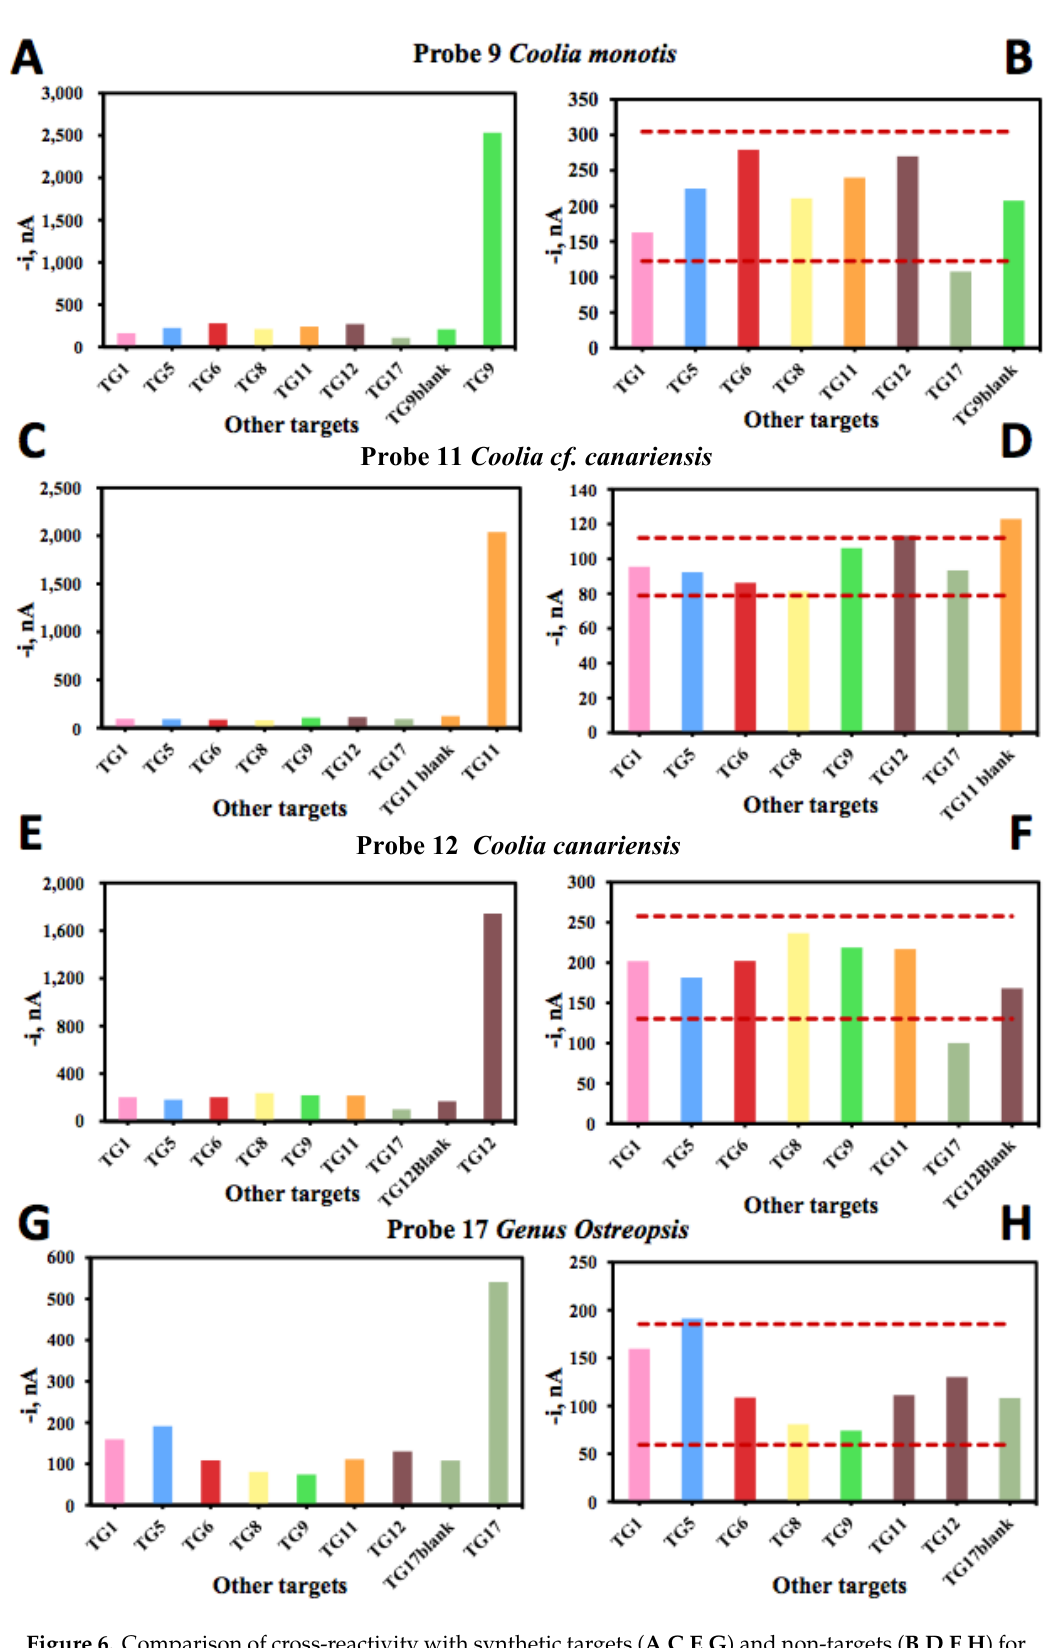
Figure 6. Comparison of cross-reactivity with synthetic targets ( A , C , E , G ) and non-targets ( B , D , F , H ) for Coolia and Ostreopsis probes. +/ − 1 × SD is plotted on the panels to the right to illustrate the signal di ff erence between only non-targets and the blank (no